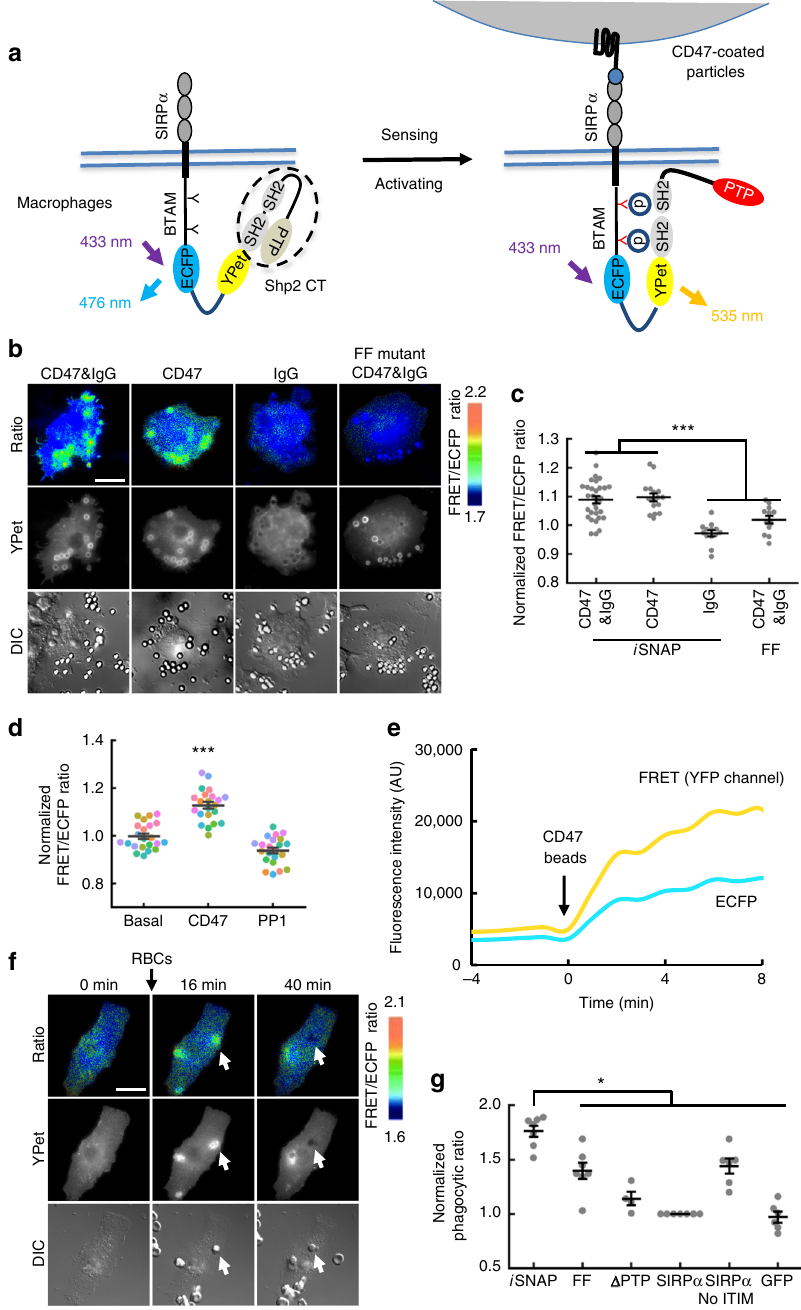
Fig. 2 The activation and phagocytic functions of SIRP α Shp2- i SNAP in macrophages. a Schematic representation of the drawing of the SIRP α Shp2- i SNAP and its putative activation mechanism upon CD47 engagement. SIRP α Shp2- i SNAP contains a human SIRP α without its ITIM-containing C-tail, fused to the Shp2- i SNAP. b Images of RAW264.7 macrophages expressing SIRP α Shp2- i SNAP or FF mutant after incubation with beads coated by CD47 plus IgG, CD47 only, or IgG only, respectively. c Quanti fi cation of local FRET response in macrophages as represented in b ( n = 32, 16, 13, 12). d The FRET ratio of SIRP α Shp2- i SNAP in response to CD47-coated beads and 10 μ M SFKs inhibitor PP1 treatment in macrophages ( n = 22, 22, 22). The same colored dots represent data obtained from the same cell. e The time course of FRET and ECFP fl uorescence intensities of one cell from d . The increase of FRET intensity is greater than that of ECFP, so the calculated FRET/ECFP ratio increases compared to before CD47 beads addition. f Images of phagocytosis of opsonized RBCs by a representative RAW264.7 macrophage expressing SIRP α Shp2- i SNAP at indicated time points. Arrows indicate ingested RBCs. g Dot plot of normalized phagocytic rate (mean ± s.e.m.) of macrophages expressing SIRP α Shp2- i SNAP or its controls against opsonized RBCs ( ‘ FF ’ , phenylalanine mutations replacing two tyrosines in the BTAM peptide; ‘ Δ PTP ’ , SIRP α Shp2- i SNAP without PTP domain; ‘ SIRP α ’ , full-length SIRP α fused with YPet; ‘ SIRP α -no ITIM ’ , ITIM-truncated SIRP α fused with YPet) ( n = 7, 7, 4, 7, 6, 6). * P < 0.05, *** P < 0.001 (two-sided Mann – Whitney U -test adjusted for multiple group comparison). Scale bars , 20 μ